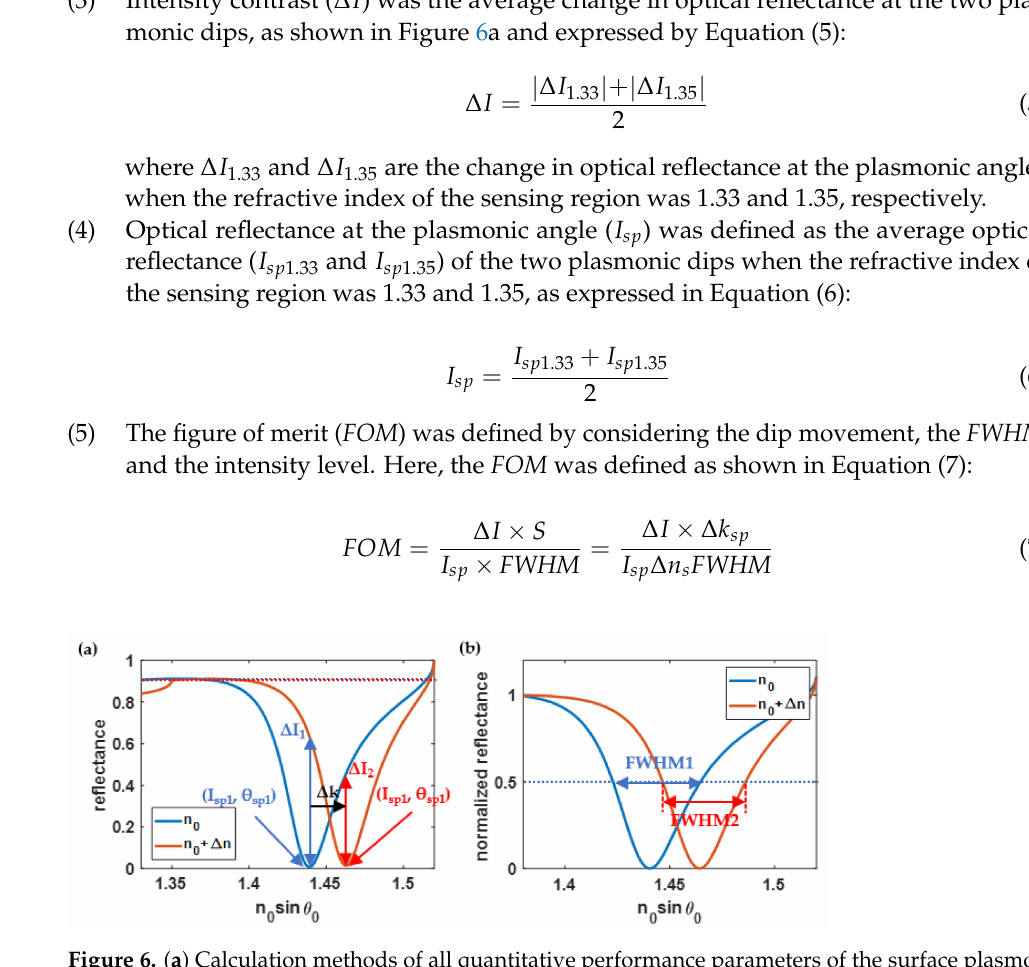
Figure 6. ( a ) Calculation methods of all quantitative performance parameters of the surface plasmon resonance detection; and ( b ) normalized optical reflectance and the full width at half maximum